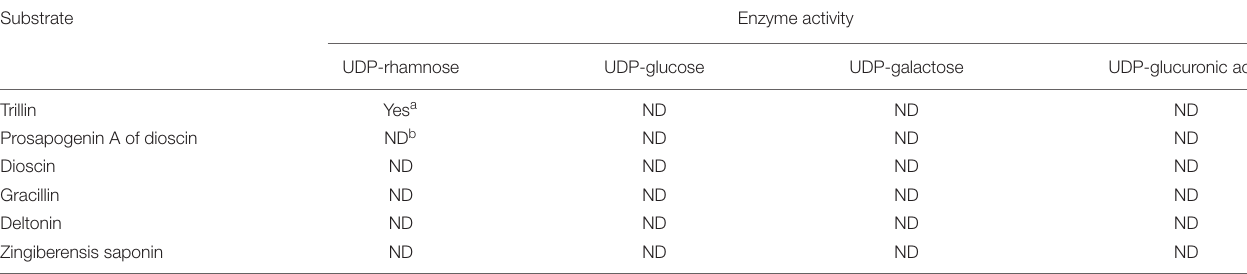
TABLE 1 | Enzymatic activities of the purified recombinant DzGT1 toward a range of substrates in vitro . Substrate